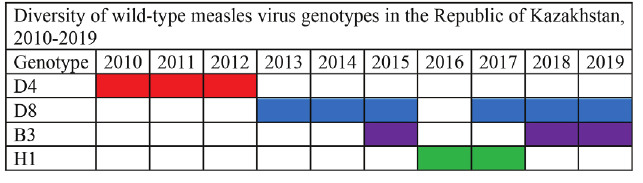
Measles does not have gender selectivity, but literature